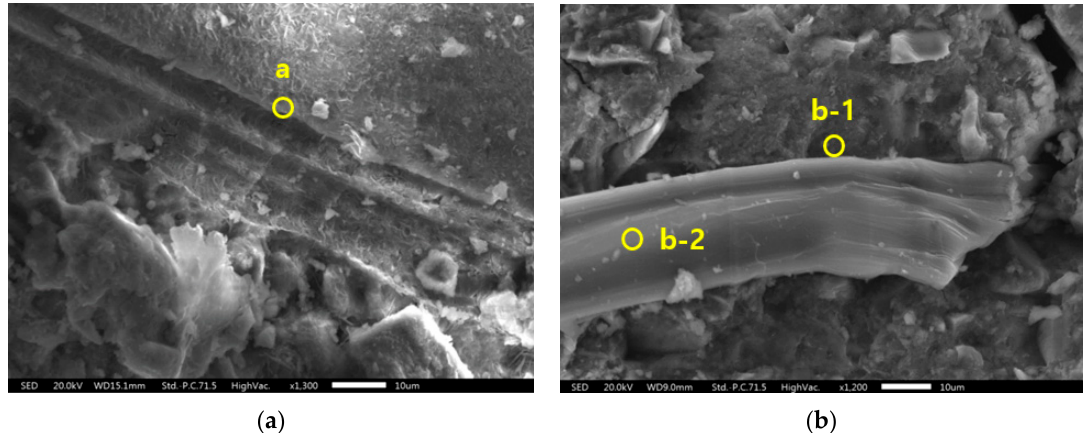
Figure 11. SEM images: ( a ) W21-S0 specimen and ( b ) W21-S5 specimen.